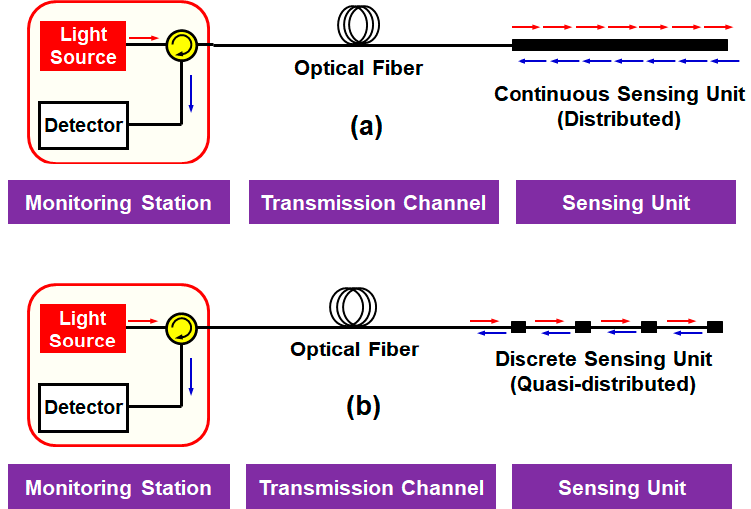
Figure 2. Classification of optical fiber sensor network architectures (point-to-multipoint) according to the spatial distribution of the measurement points: ( a ) distributed and ( b ) quasi-distributed.